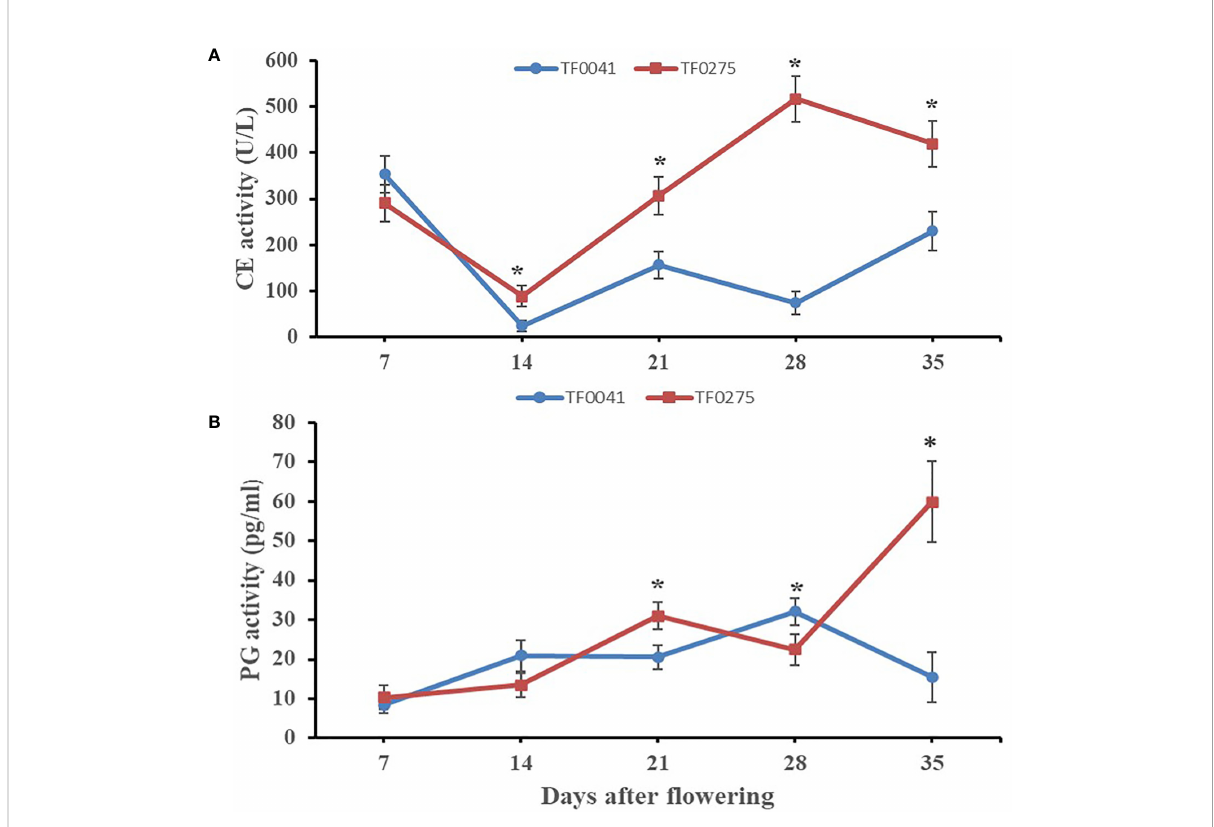
FIGURE 4 Speci fi c activity of two cell wall-degrading enzymes, cellulase (CE) (A) and polygalacturonase (PG) ( B ), in the abscission zone. Bars indicate the mean ± SD. Asterisk indicates a signi fi cant difference in the enzyme activity between TF0041 and TF0275 at the p < 0.05 level.